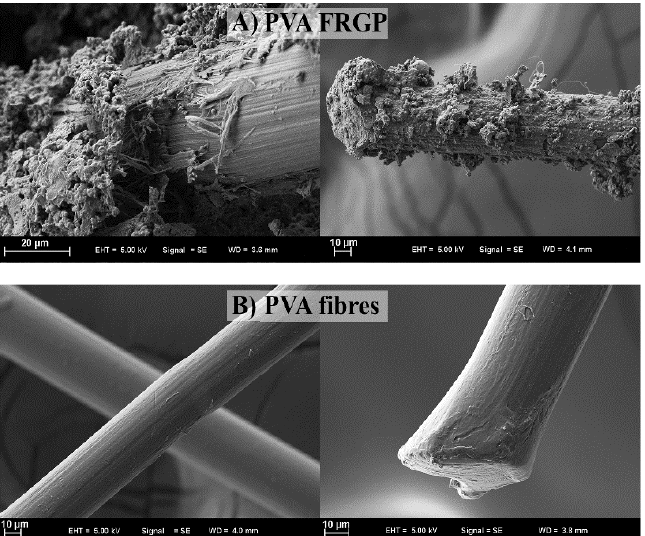
Figure 18. SEM images of 10% slag replacement of geopolymer mortar: ( a ) control sample; ( b ) 10% DSF; ( c ) 10% USF [106]. (Reprinted with permission from the publisher, Elsevier; License No. 5471711440902).